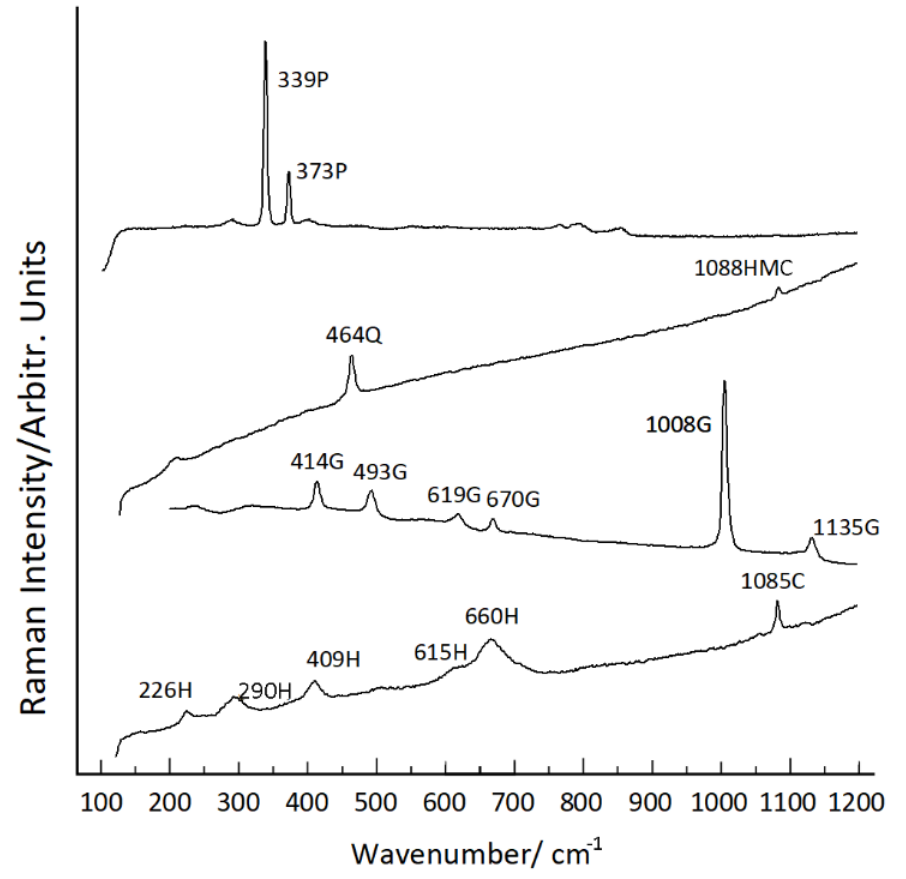
Figure 7. Raman spectra collected on carbonatic black samples, in which high magnesium calcite (HMC), quartz (Q), hematite (H), pyrite (P) and gypsum (G) signals are identified. In order to further ascertain the type and/or amount of aluminosilicates present in the black tesserae of carbonate nature, XRD measurements were performed on selected samples. On this sample set, a percentage of aluminosilicate between 5 and 10% was found, with the relative proportion between calcite and quartz being approximately 84% and 16%, respectively. Therefore, all the findings suggested that the black tesserae belonging to the first group could correspond to the local typical deep grey/black marly limestone [65–69]. The Raman spectra collected on volcanic tesserae showing high-K content (Figure 8) (samples from Rooms 1 and 28, see Figure 6c,d) often showed the iron in the form of hematite. Moreover, pyrite was not found in these samples, in agreement with the PC1 vs. PC2 representation, where S was negatively correlated with Fe. On the contrary, quartz (signal at 465 cm − 1 ) and even apatite (Ca 5 (PO 4 ) 3 (F, Cl, OH), signals at 428, 445, 580, 589, 605, 614, 963, 1033 and 1058 cm − 1 ) were also identified in this type of sample, in agreement with the concentration values of Si and P observed in the samples. In addition, different compounds of magmatic origin such as leucite (KAlSi 2 O 6 , signals at 149, 183, 497 and 529 cm − 1 ), unoriented nepheline ((Na,K)AlSiO 4 , signals at a 203, 267, 352, 398, 464, 995 and 1086 cm − 1 ) and calcium diopside (CaMgSi 2 O 6 , signals at 137, 319, 350, 386, 664, 853 and 1011 cm − 1 ) were frequently found. The detection of leucite in the high-K samples also explains both the high amount of K and the correlation among K, Al and Si in the loading plot (Figure 6d) of black tesserae